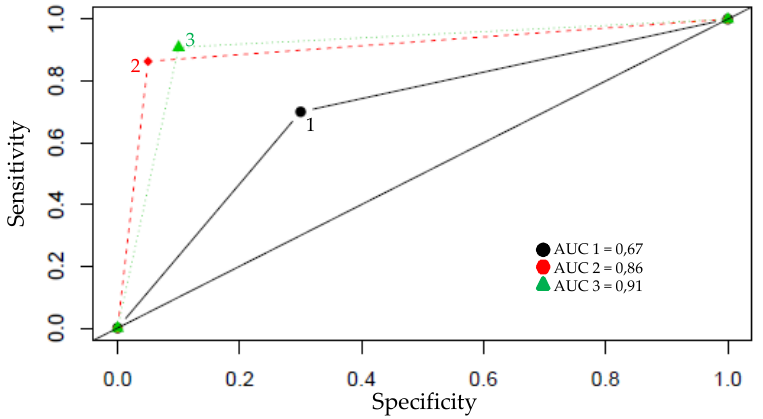
Figure 1. ROC curves and the area under the ROC curve (AUC).